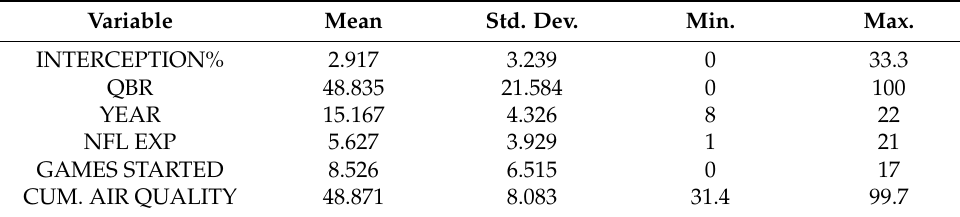
Table 4. Descriptive statistics for NFL sample.